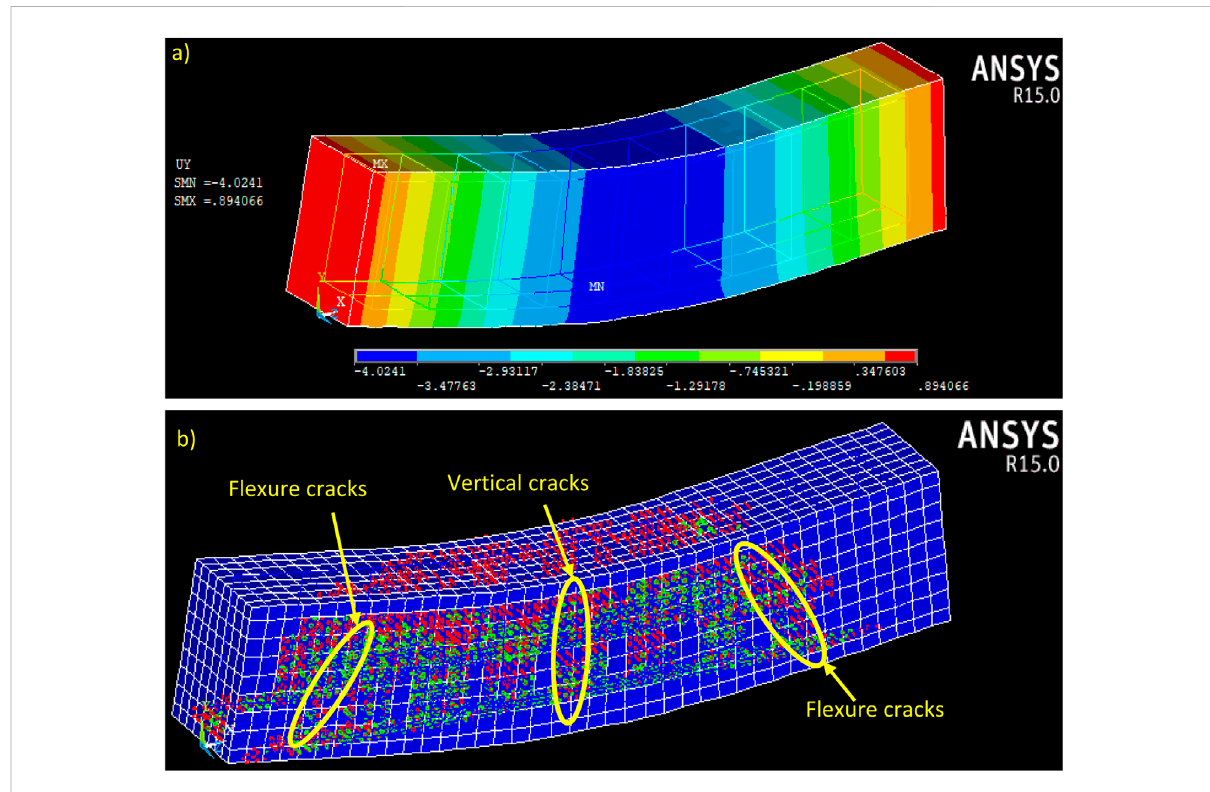
FIGURE 14 Bottom ash added to concrete causes cracks in the RCB. Bottom ash increases the width of the cracks. 3D fi nite element analysis results are displayed in (A) as a contour plot and (B) showing the